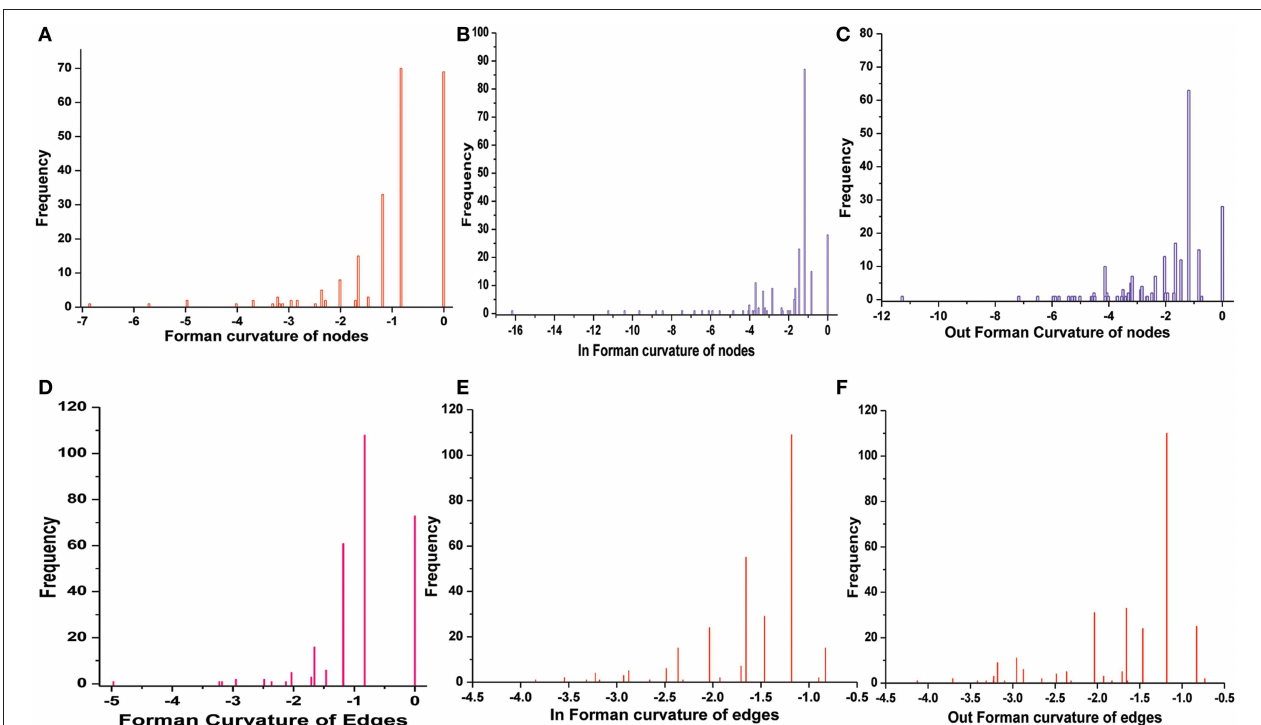
FIGURE 4 | Distribution of Forman curvature of directed edges and nodes in master (M) network. (A) Forman curvature of nodes, (B) In Forman curvature of nodes, (C) Out Forman curvature of nodes, (D) Forman curvature of Edges, (E) In Forman curvature of edges, (F) Out Forman curvature of Edges.